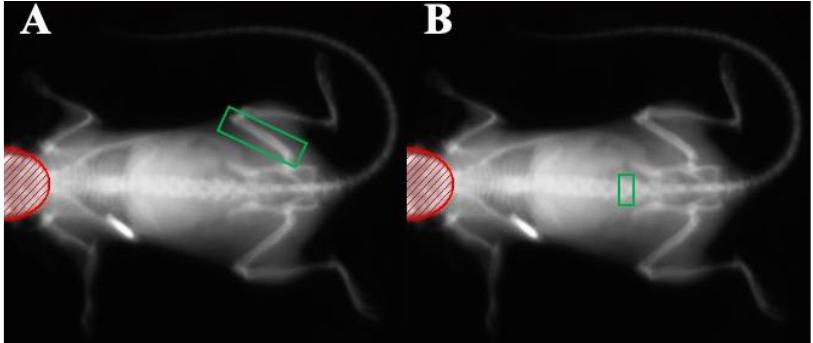
Figure 1 . Representative DXA scanning images of a C57BL/6 mouse. ( A ) A scan with the ROI placed around the distal condyles, diaphysis, and a portion of the femoral neck (femoral head and pelvis excluded from ROI), and ( B ) the same scan with the ROI placed around the L5 vertebra. The region of interest (ROI) is shown in green. The bright white object at the left scapular region is the implanted subcutaneous microchip used for animal identification.